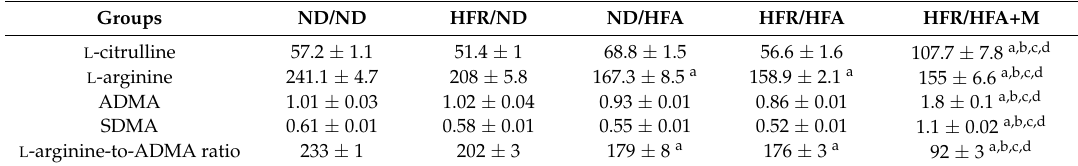
Table 2. Plasma L -citrulline, L -arginine, ADMA, and SDMA levels in 12-week-old male offspring exposed to high-fructose diet (HFR), high-fat (HFA) diet, and metformin (M).